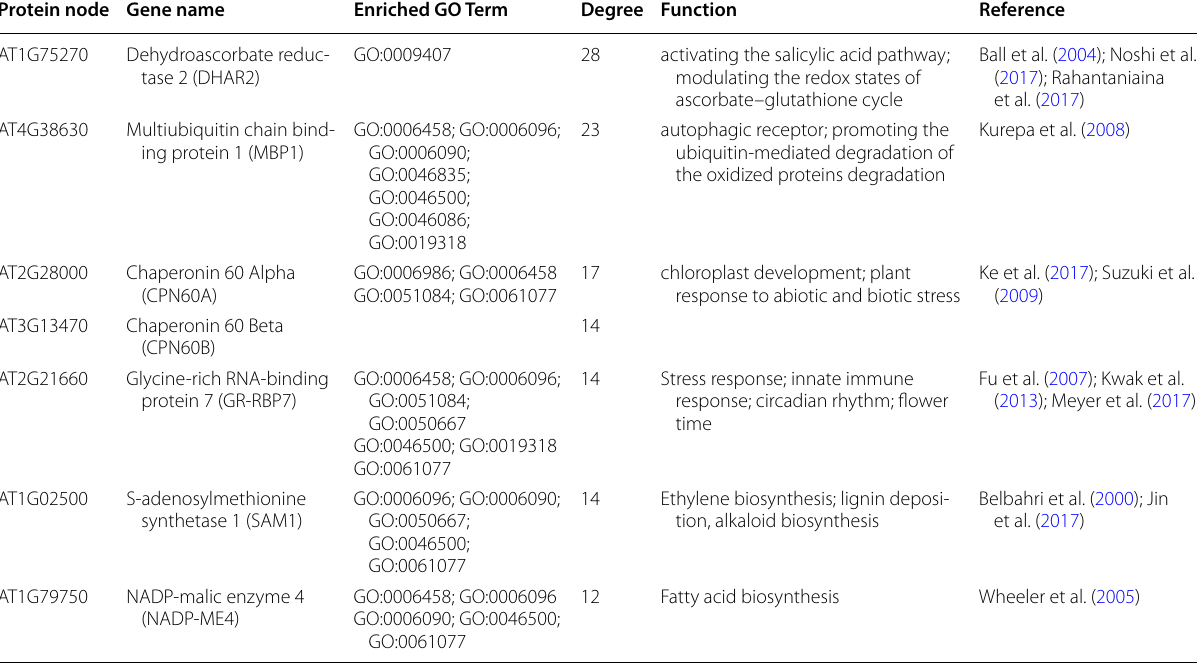
Table 3 Function analysis of the proteins with more than 10 interacting partners in the PPI network Protein node Gene